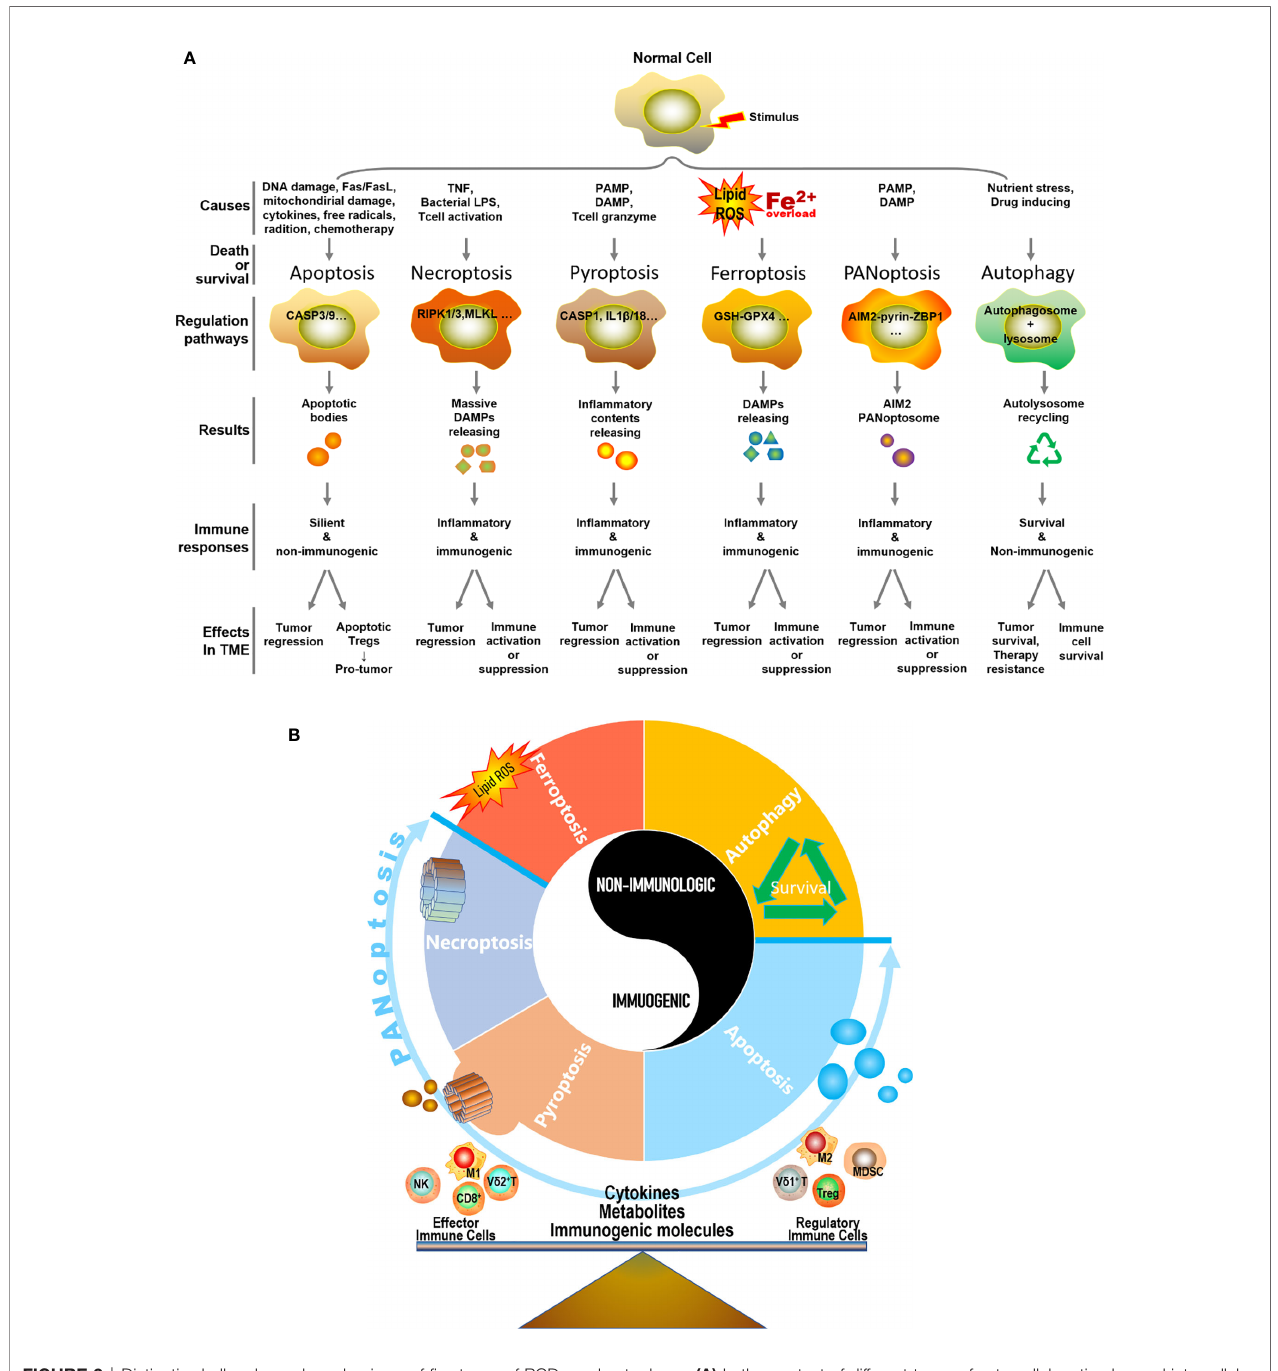
FIGURE 2 | Distinctive hallmarks and mechanisms of fi ve types of PCDs and autophagy. (A) In the context of different types of extracellular stimulus and intracellular signaling, a normal cell may undergo a speci fi c type of cell death or survival. This process is precisely regulated by a set of genes and signaling molecules. Necroptosis, pyroptosis, ferroptosis, and PANoptosis represent four typical ways of immunologic PCD in the TME, which releases various cytokines, metabolites, and immunogenic molecules, thus leading to either tumor regression accompanied by immune activation or tumor progress along with immune suppression. For non-immunologic apoptosis in the TME, it generally connects with tumor regression, however, immune cells in the TME are routinely apoptosis-activated as well and implicate with the depressed immune microenvironment. Particularly, apoptotic regulatory T cell (Treg) can serve as a strong pro-tumor player in the TME. As for autophagy (self-survival dominantly) in the TME, it is closely linked with cancer cell survival, tumor progress, and therapy resistance. Meanwhile, immune cells also adopt autophagy strategy to survive in the stressful condition of the TME, and to eventually perform either pro-tumor or anti-tumor function depending on circumstances. (B) Apoptosis, necroptosis, pyroptosis, ferroptosis, PANoptosis, and autophagy, as well as their respective produced cytokines, metabolites, and immunogenic molecules in the TME, collaboratively participate in balancing the TME to enrich either anti-tumor effector immune cells or regulatory immune cells, eventually lead to tumor regression or